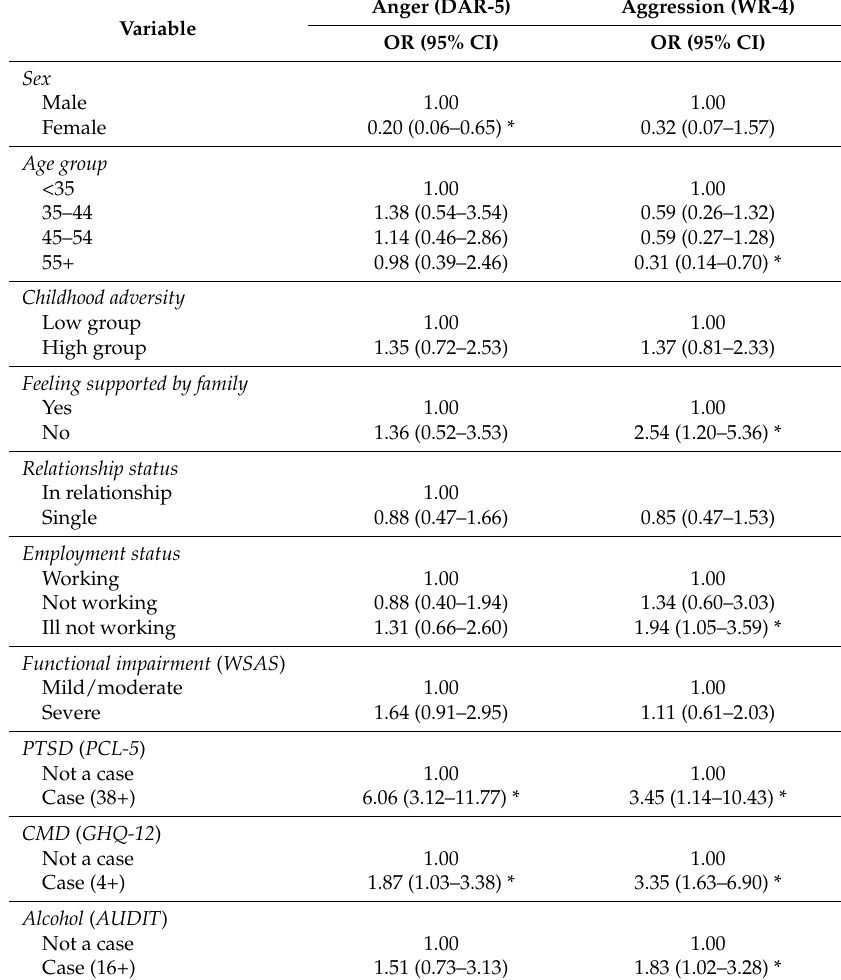
Table 4. Exploring associations with anger and aggression adjusting for all other significant variables previously